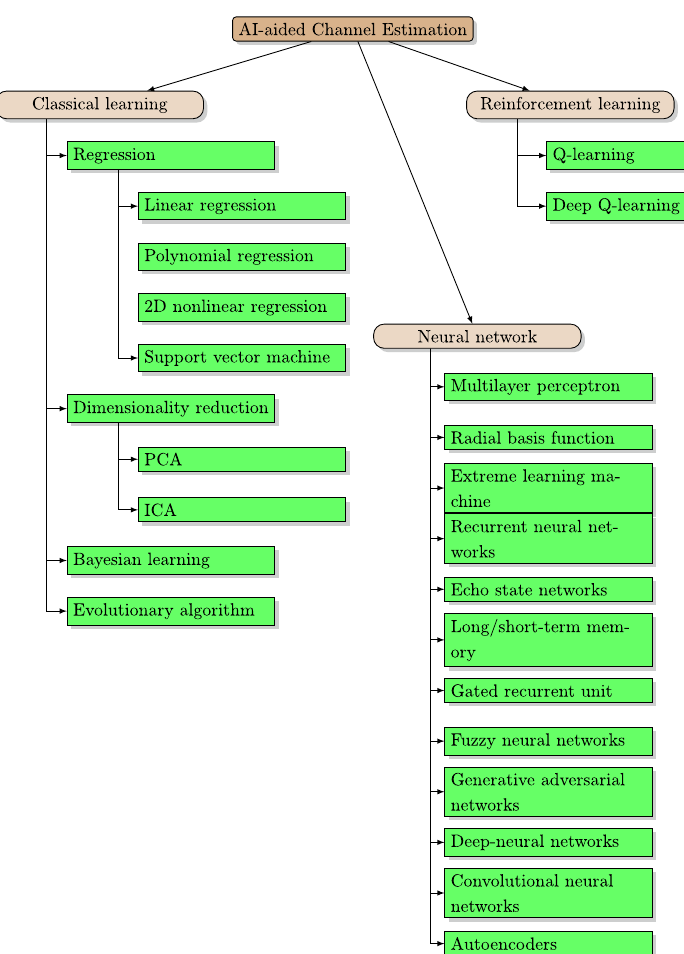
Fig. 5 Classification of AI-aided channel estimation